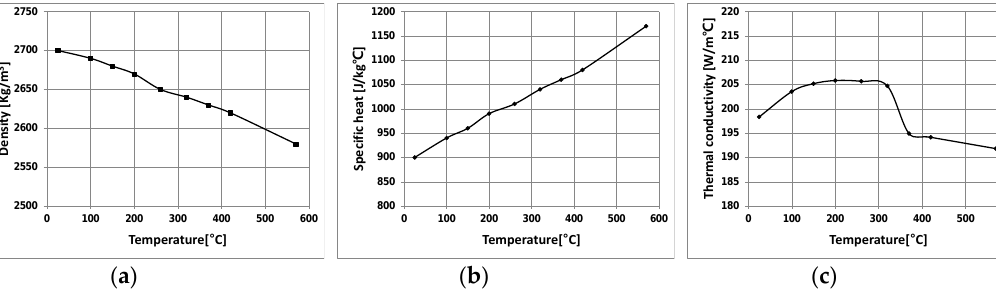
Figure 10. Temperature-dependent material properties for heat transfer analysis: ( a ) density; ( b ) specific heat; ( c ) thermal conductivity.